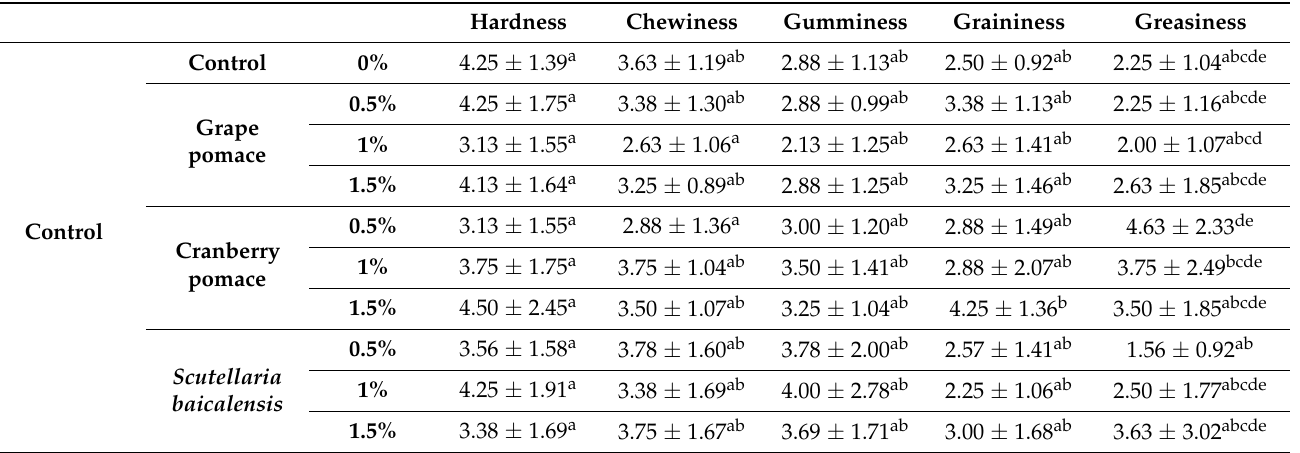
Table 2. Changes in textural profile by way of hardness, chewiness, gumminess, graininess, and greasiness across the various marinated oven-grilled chicken breast meat samples compared to the